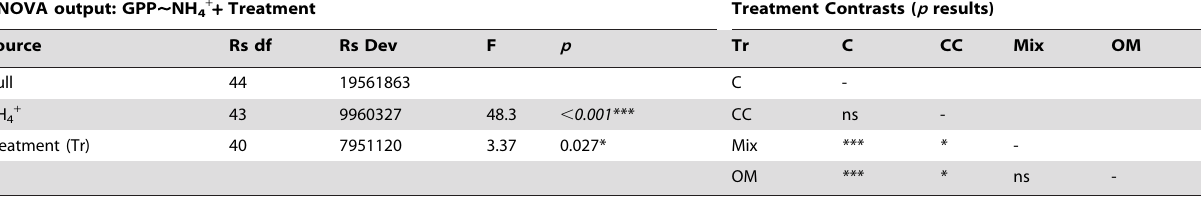
Table 2. ANOVA output from the GLM Model 1b from Table 1 (Gaussian distribution, identity link function) indicating the significance of ammonium uptake (NH 4 + ) on gross primary production (GPP) among treatments (OM: Organic matter, CC: Calcium carbonate, Mix: OM + CC, and C: Control).